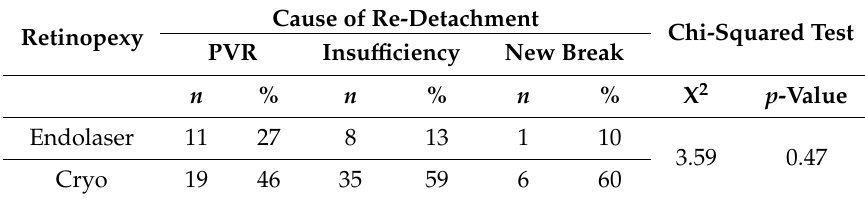
Table 2. Significance of association between retinopexy methods and cause of re-detachment.